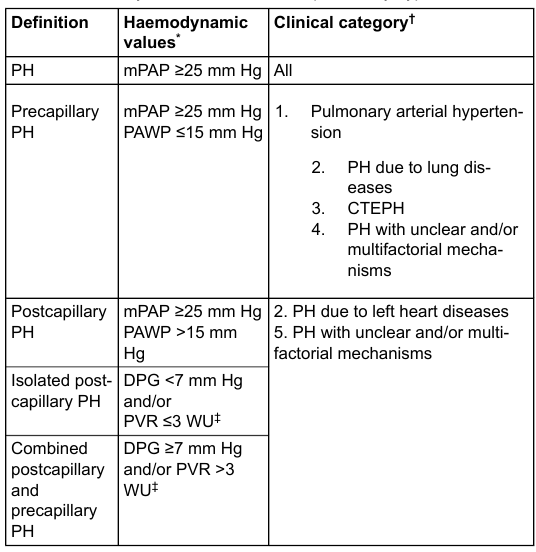
Table 2: Haemodynamic classification of pulmonary